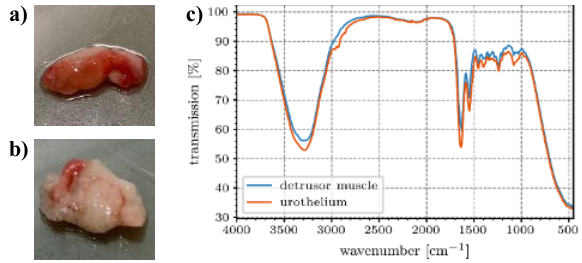
Fig. 1. Investigated samples of a) urothelium, b) detrusor muscle and c) mean spectra of the two investigated spectra. The correlation coefficient between both spectra is 99.75